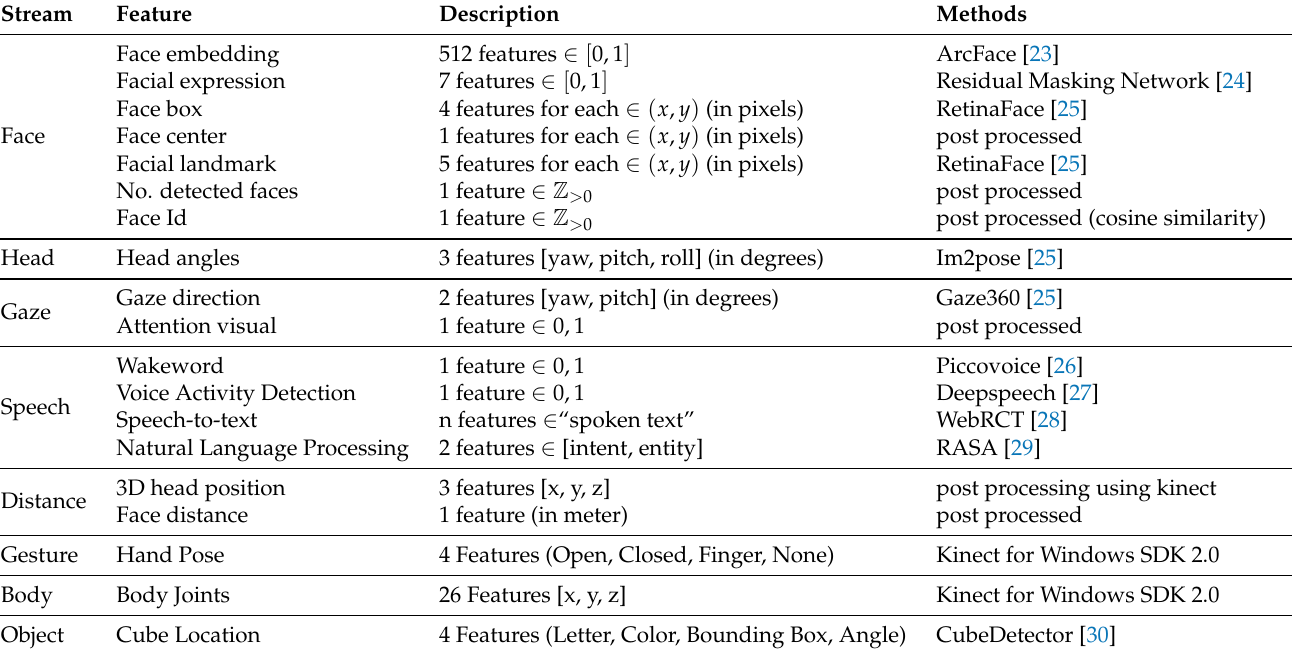
Table 1. Extracted feature stream.